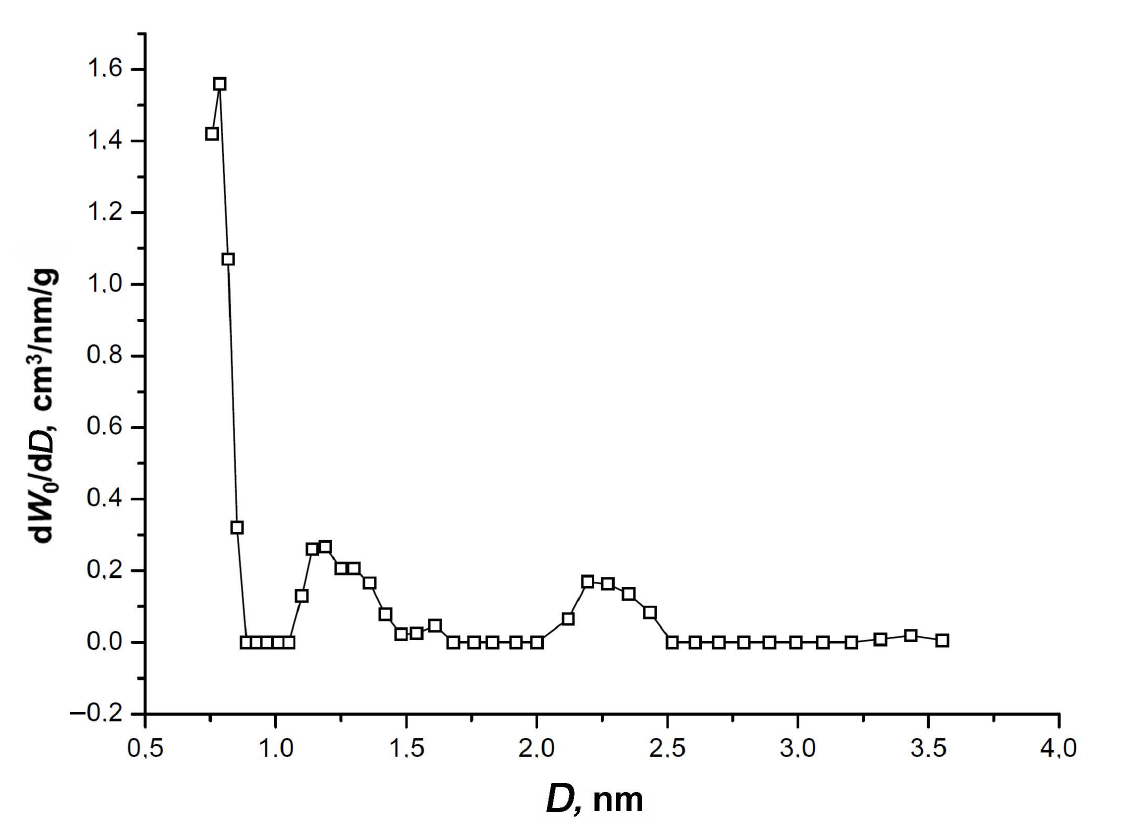
Figure 3. The pore size distribution of SiC-AC calculated by the non-local density functional theory (NLDFT) model for a combined slit + cylinder pore geometry from the nitrogen adsorption isotherm at 77 K